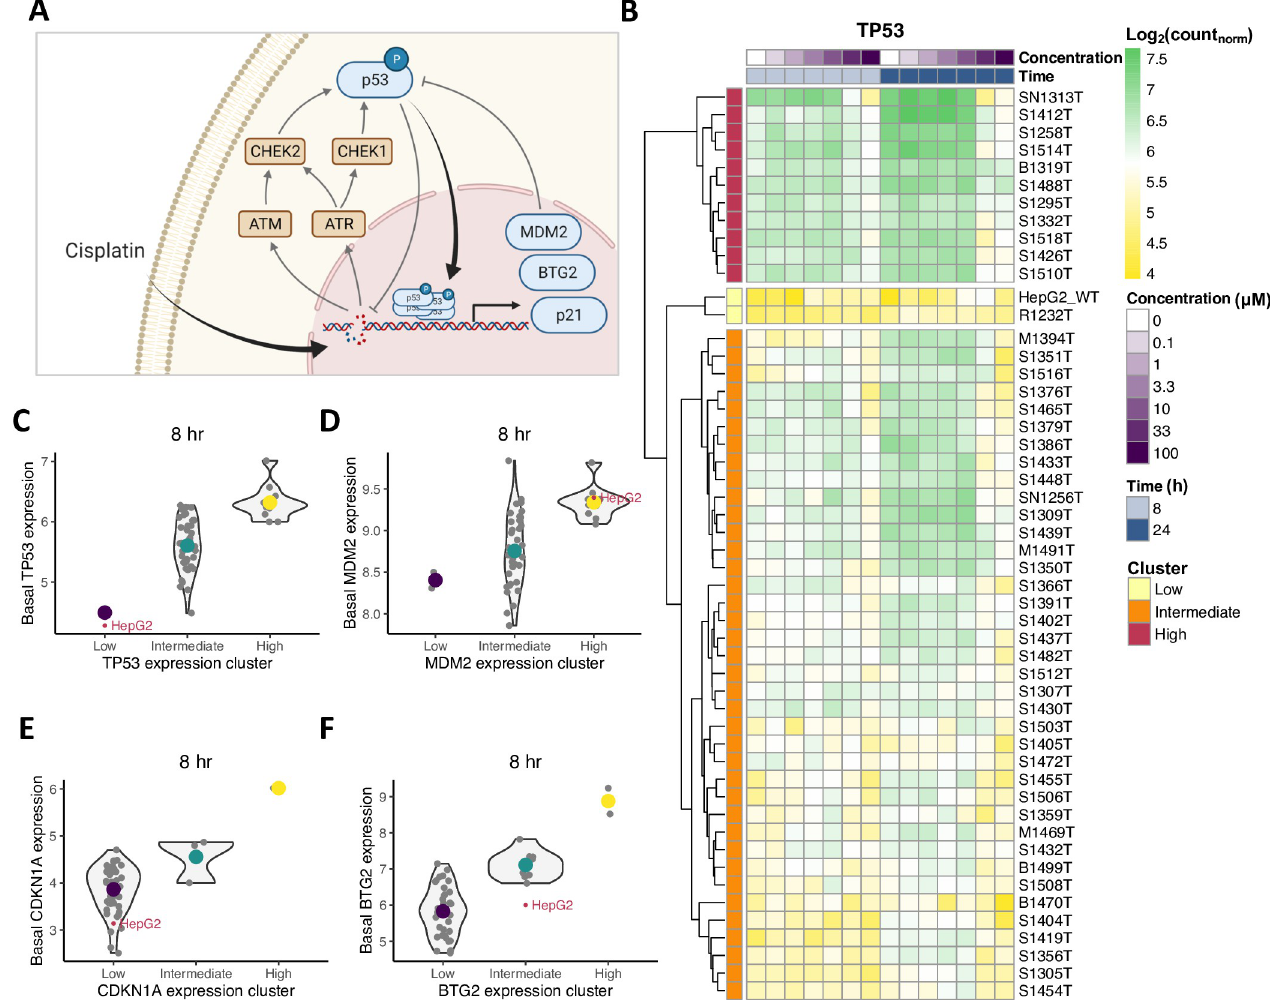
Fig 1. Variability in basal and cisplatin-induced gene expression in HepG2 cells compared to PHHs from donor samples. (A) Graphical representation of DNA damage-induced protein signaling upon cisplatin exposure. Kinases ATM, ATR, CHEK1 and CHEK2 are activated upon DNA damage and phosphorylate transcription factor p53. Phosphorylated p53 enters the nucleus and induces transcription of downstream targets, among which are MDM2, p21 and BTG2. (B) TP53 expression in HepG2 and 50 PHH donor samples without and after cisplatin exposure. HepG2 cells cluster with one low TP53 -expression PHH donor sample. (C-F) Basal expression of TP53 (C), MDM2 (D), CDKN1A (E) and BTG2 (F) in PHHs and the HepG2 cell line within their corresponding low-, intermediate- and high-expression clusters. HepG2 cell line has lower basal expression levels for TP53 , CDKN1A and BTG2 , but not for MDM2 , compared to average expression in PHHs within the same cluster. Contour lines are violin plots with individual samples marked by small grey dots, and large colored dots are cluster